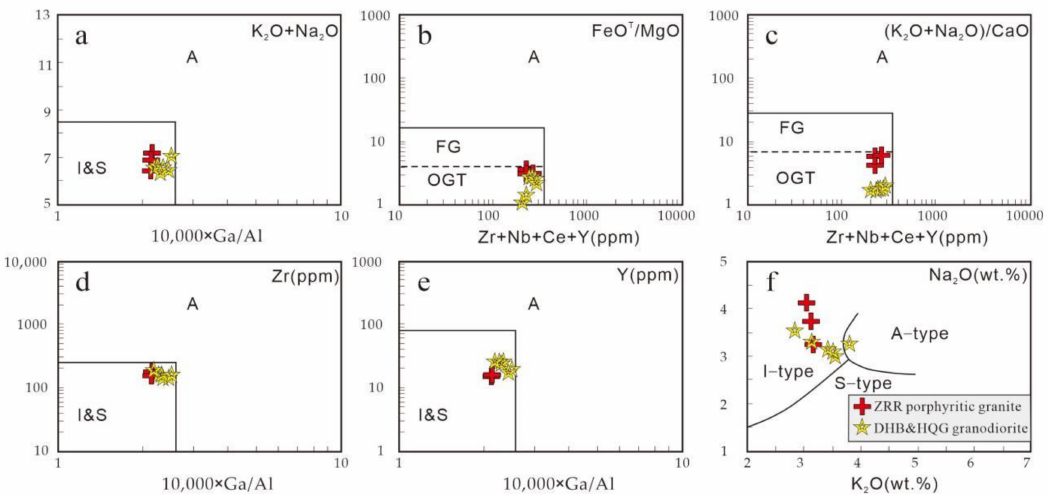
Figure 9. ( a ) (K 2 O + Na 2 O) versus 10,000 Ga/Al classification diagram; ( b ) FeO T /MgO versus (Zr + Nb + Ce + Y) classification diagram; ( c ) (K 2 O + Na 2 O)/CaO versus (Zr + Nb + Ce + Y) clas- sification diagram; ( d ) Zr versus 10,000 Ga/Al classification diagram; ( e ) Y versus 10,000 Ga/Al classification diagram (Figure 9a–e is after [34]); ( f ) Na 2 O versus K 2 O diagram (after [31]). A: A- type Granites; I&S: I- and S-type Granites; FG: Fractionated Granites; OGT: Unfractionated I and S-type